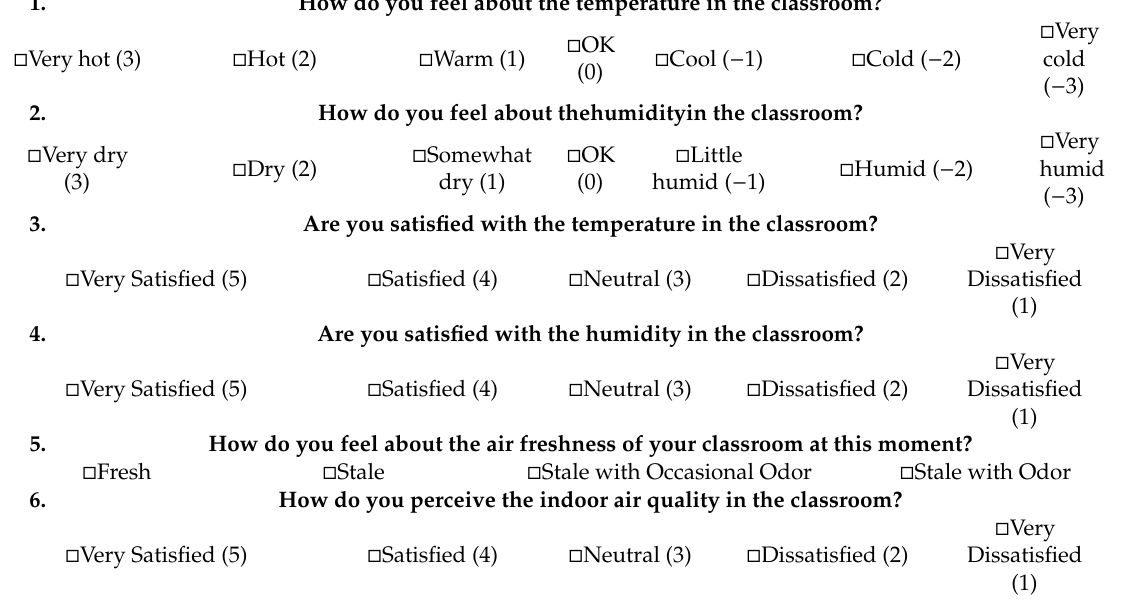
Table 3. Scales used in the questionnaire